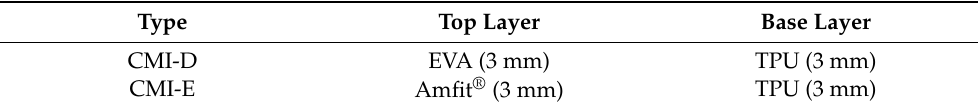
Table 2. The combination of materials for 2-layer custom-made insole.